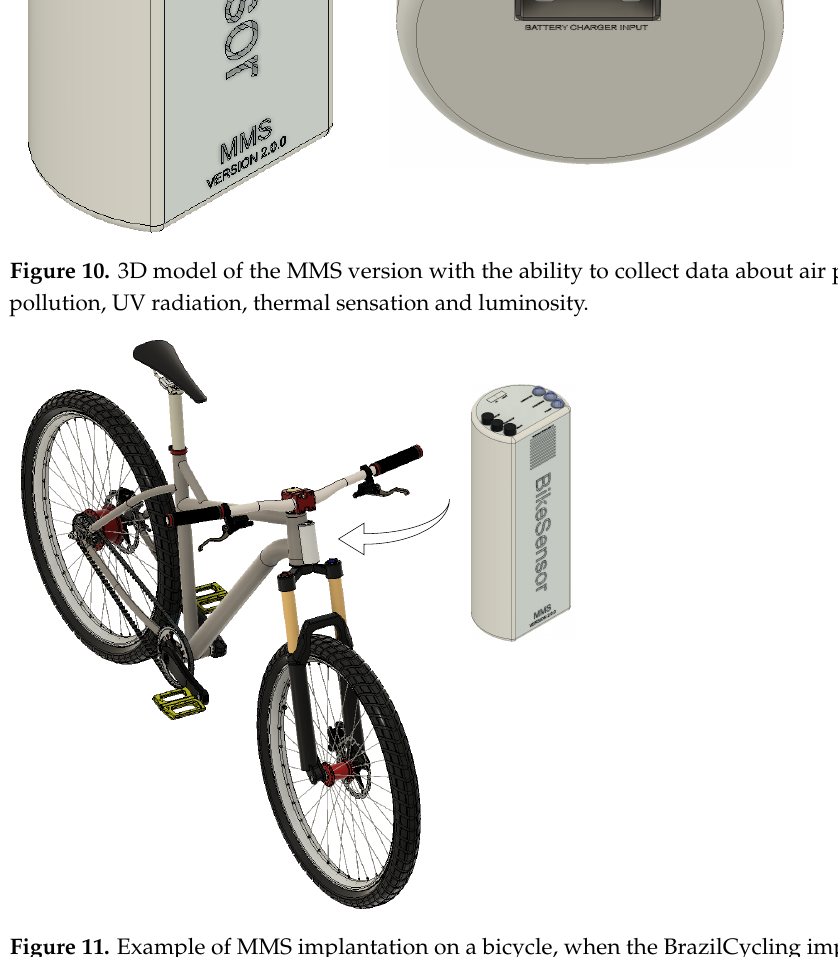
Figure 11. Example of MMS implantation on a bicycle, when the BrazilCycling implementation is adopted for the UFRN central campus